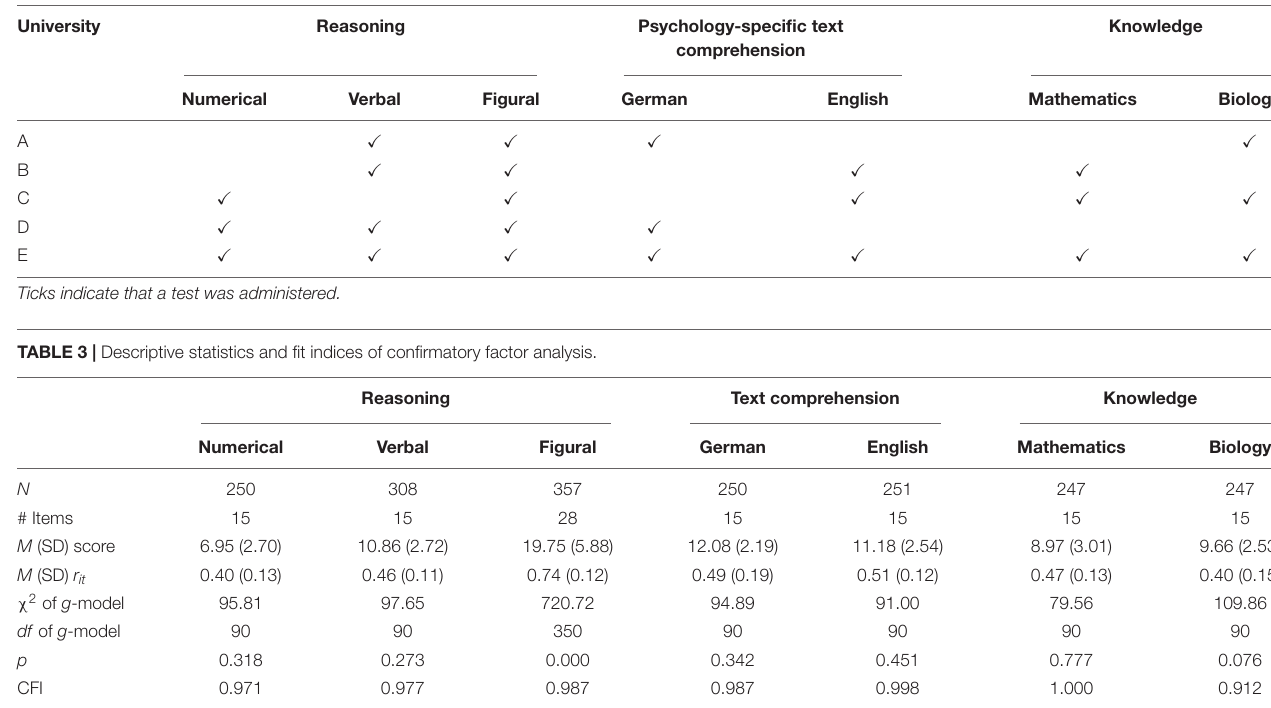
TABLE 2 | Planned-missingness design of the study.